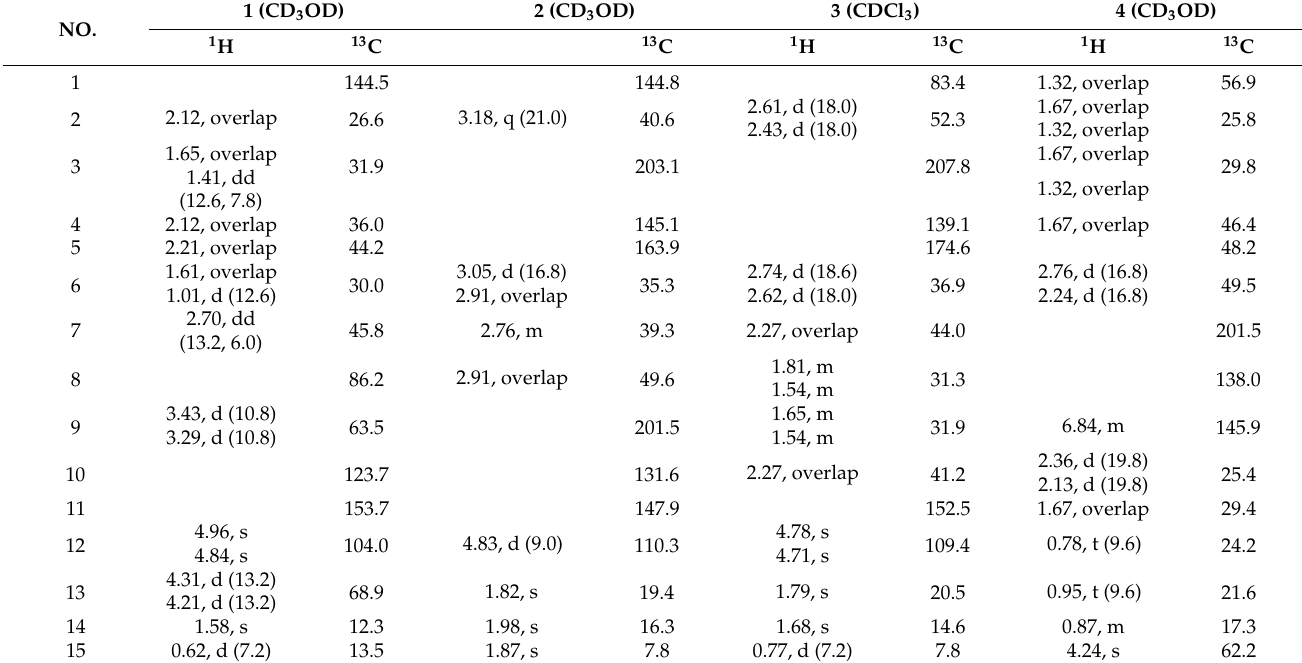
Table 2. NMR data of compounds 1 – 4